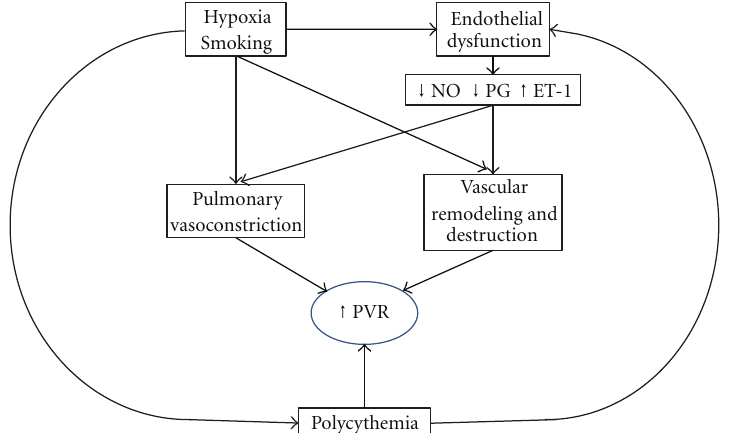
Figure 2: Pathophysiology of elevated PVR in COPD. PVR: pulmonary vascular resistance, NO: nitric oxide, PG: prostaglandin, ET-1: